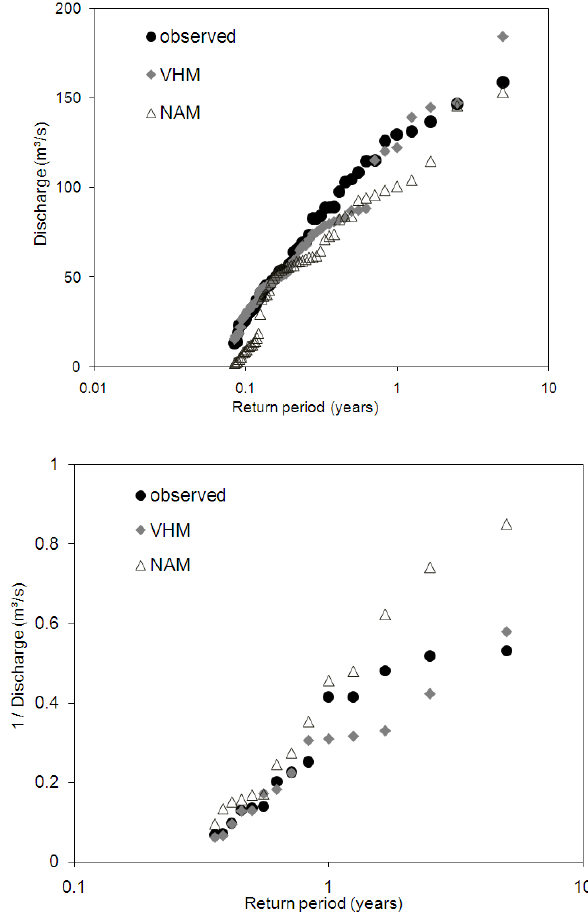
Fig. 5. Return period of daily peak flow extremes (top) and low flow extremes (bottom) for Nyando catchment: comparison of observa- tions with model results during calibration period